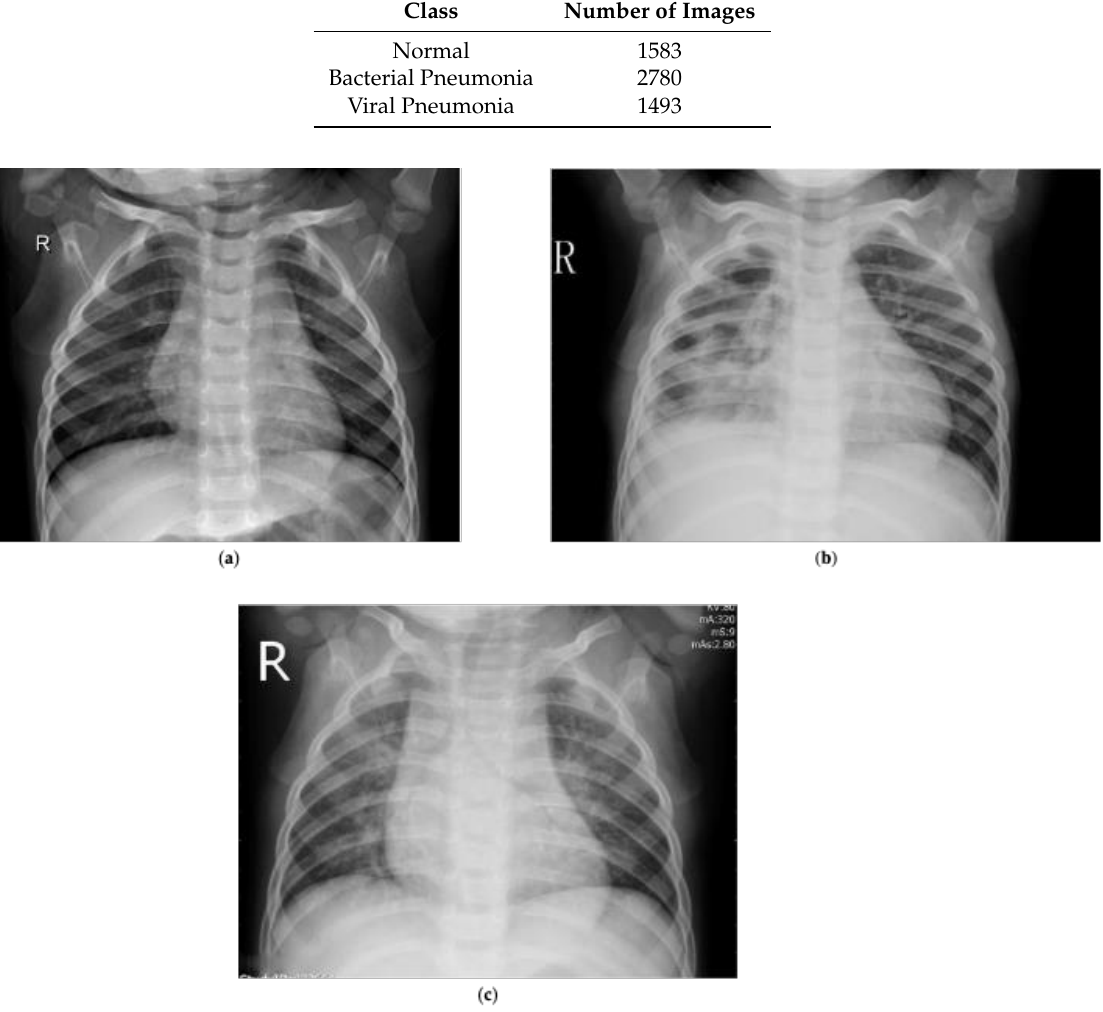
Figure 4. Chest radiograph examples from the Pneumonia dataset marked by radiologists: ( a ) normal, ( b ) bacterial pneumonia, ( c ) viral pneumonia.